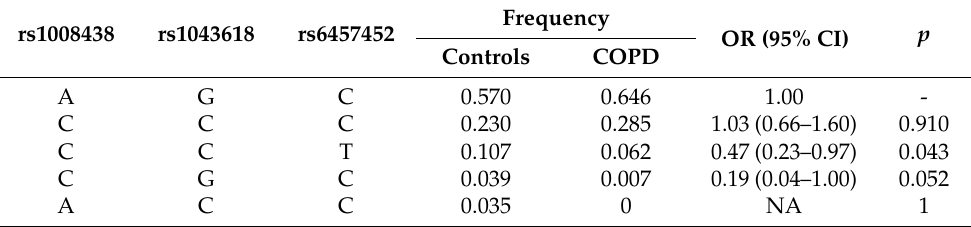
Table 8. Association analysis of HSP70 haplotypes with COPD